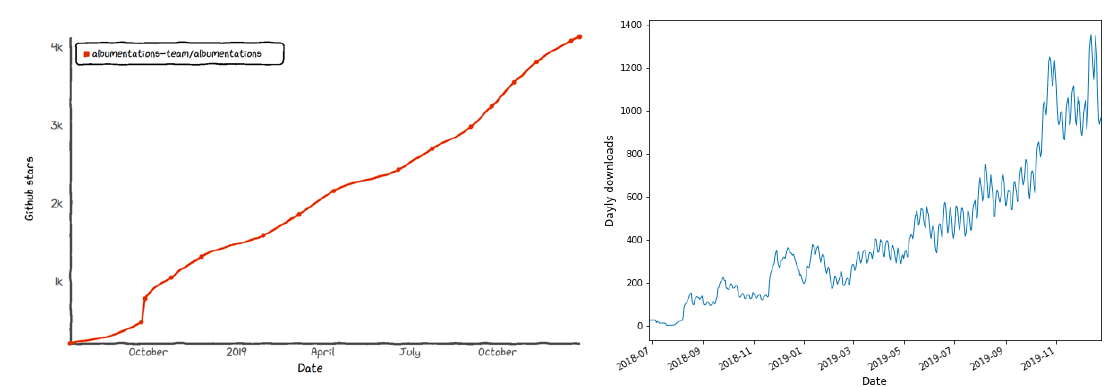
Figure 7. Library adoption shown as: ( left ) the number of stars in the Albumentations GitHub repository over time; and ( right ) the number of daily installations of the library using PyPI: pip install albumentations